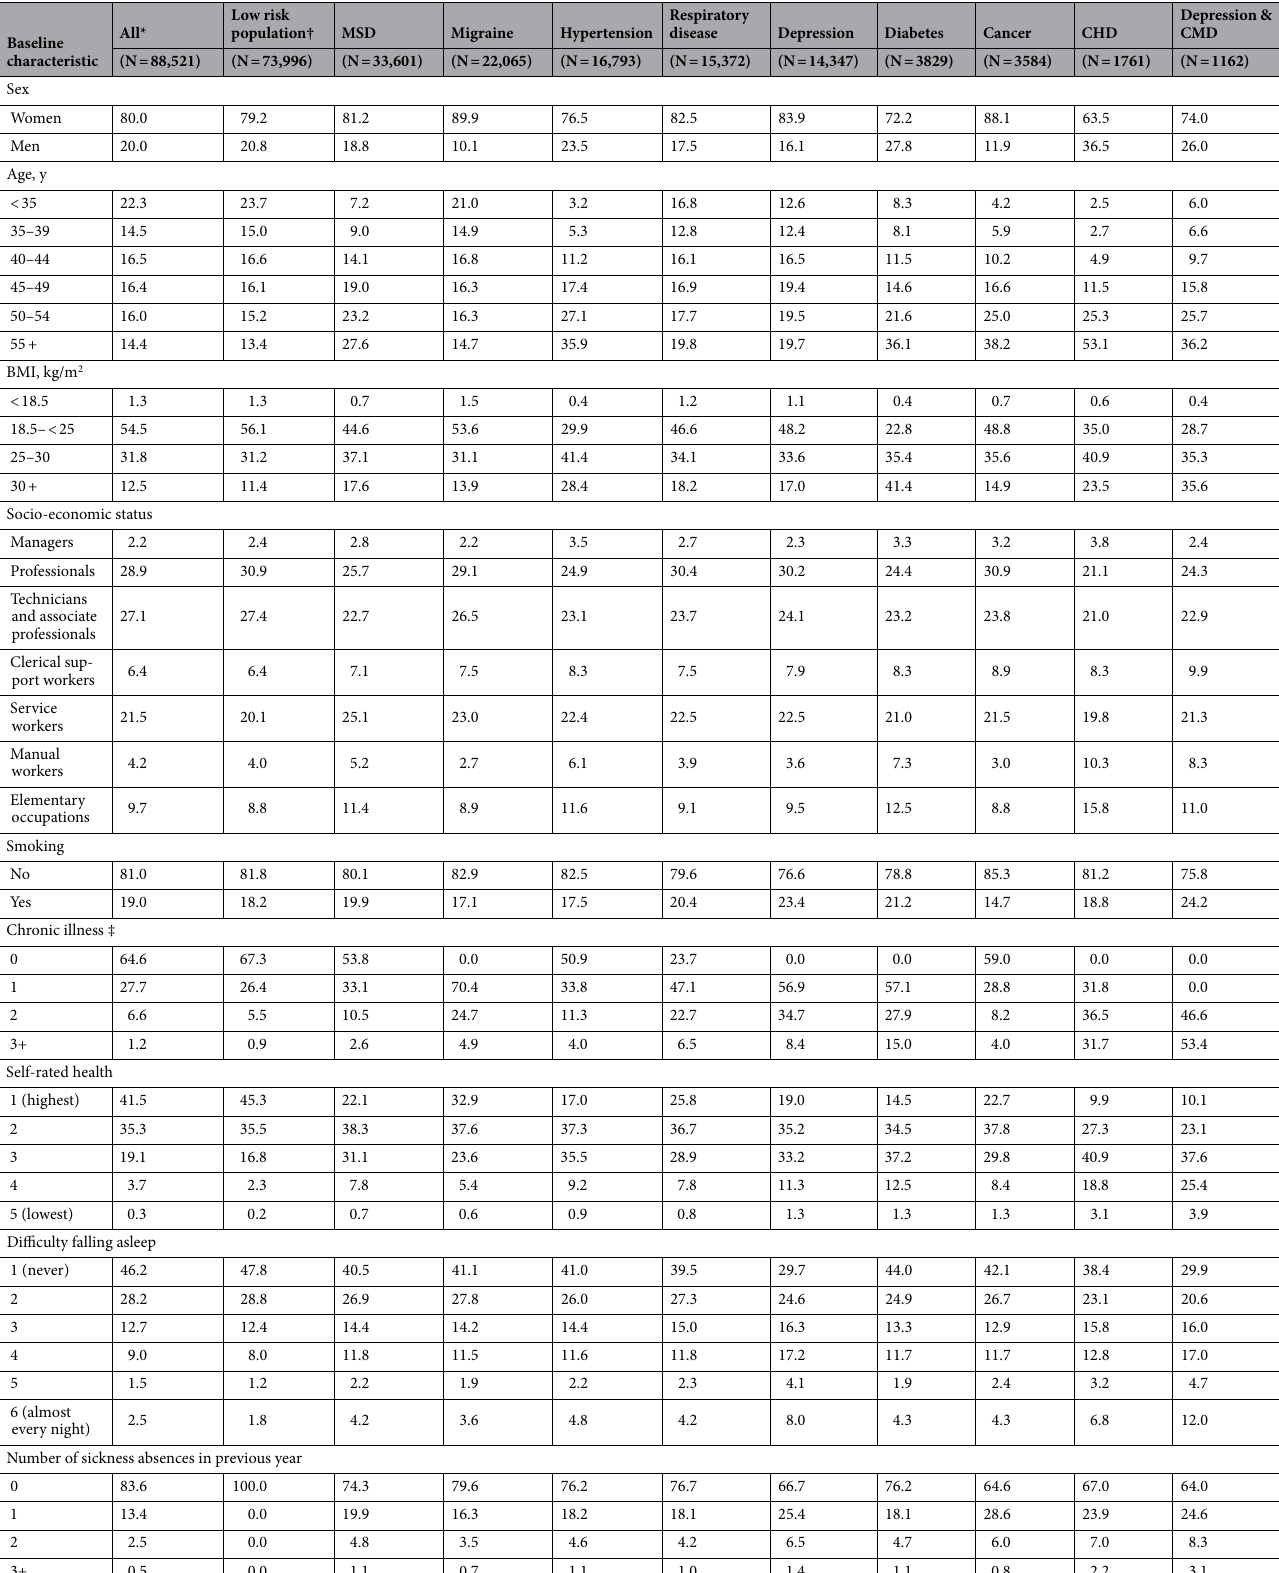
Table 2. Baseline characteristics of all participants and subgroups of individuals with no history of sickness absence and those with a chronic condition at baseline. CHD, coronary heart disease; CMD, cardiometabolic disease (diabetes or CHD); MSD, musculoskeletal disorder. *Participants with and without chronic conditions at baseline. † Participants with no sickness absence at baseline. ‡ Self-reported bronchial asthma, myocardial infarction, angina pectoris, cerebrovascular diseases, migraine, depression or